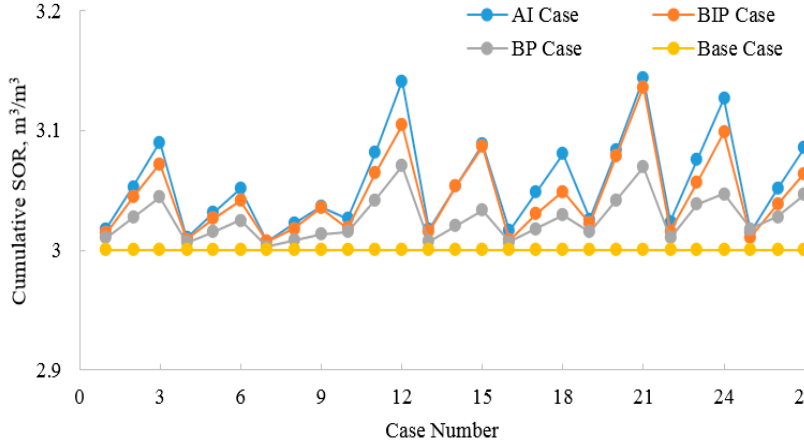
Figure 3. Comparison of SOR for three types.